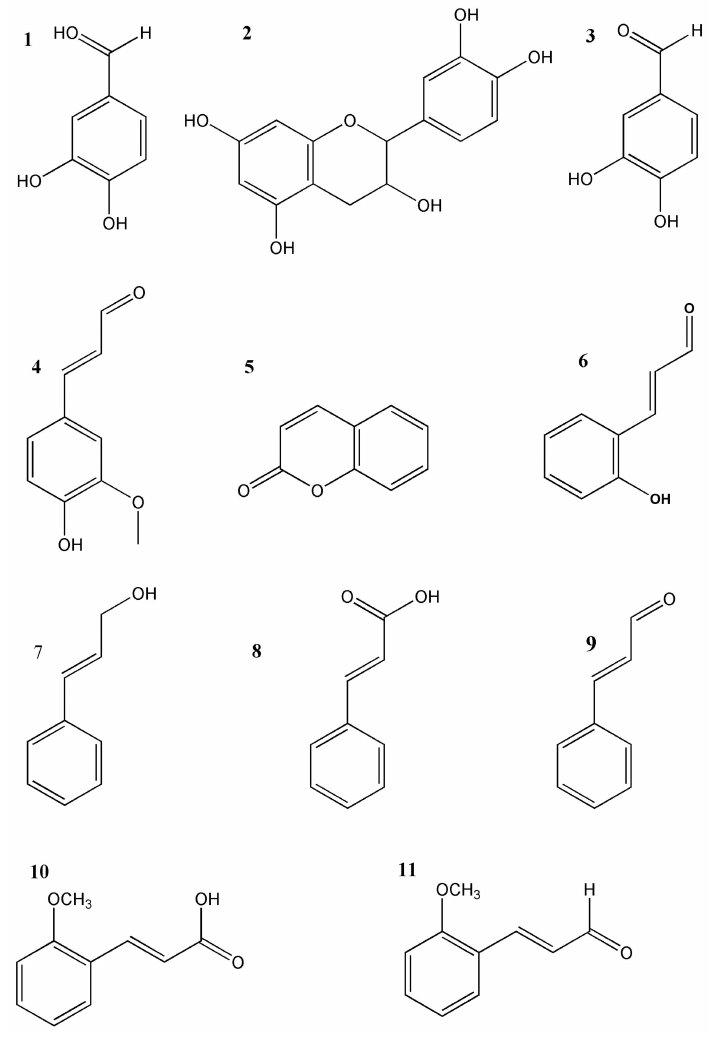
Figure 1. Chemical structures of 11 constituents in